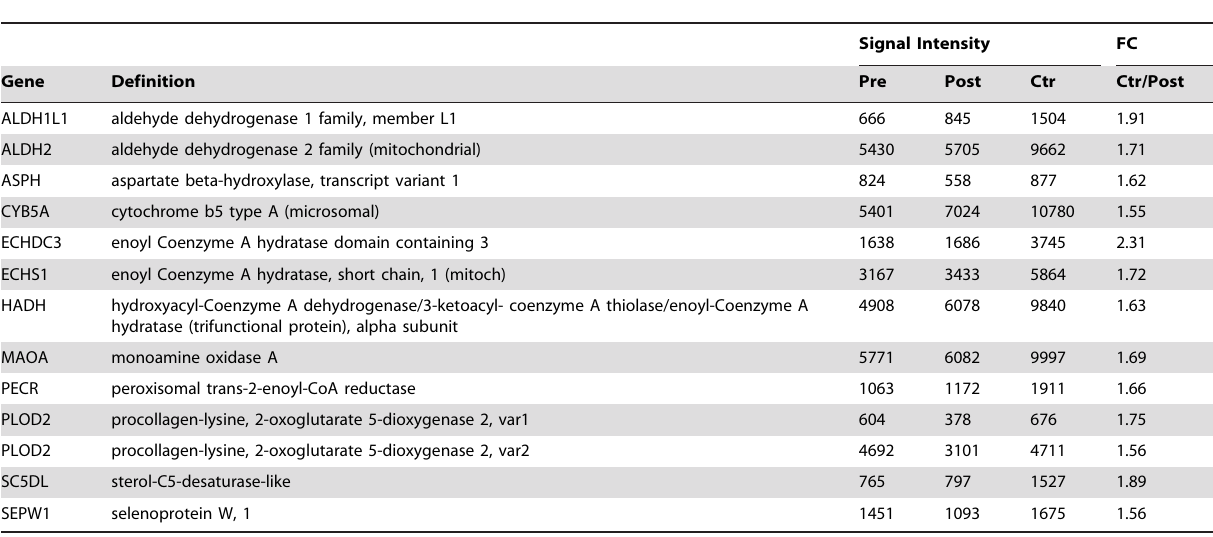
Signal Intensity